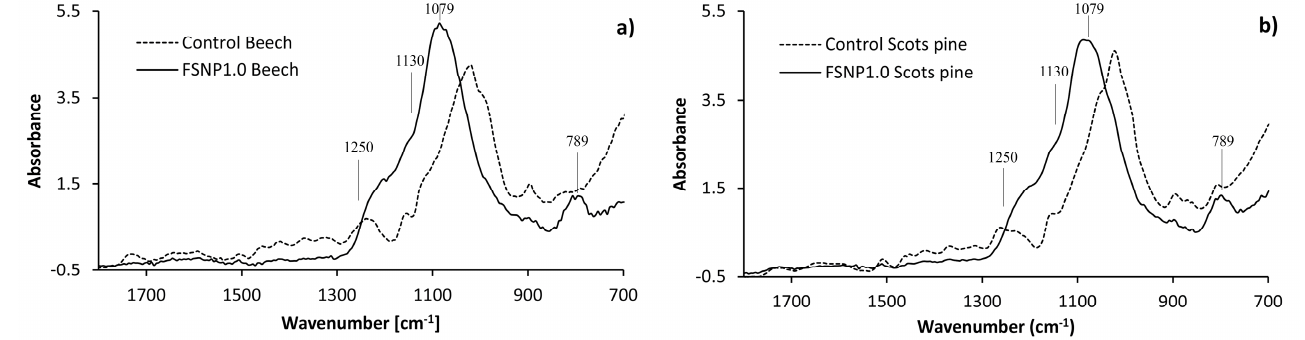
Figure 3. SNV-transformed FT-IR spectra of control and FSNP1.0-modified wood: ( a ) beech, ( b ) Scots pine.